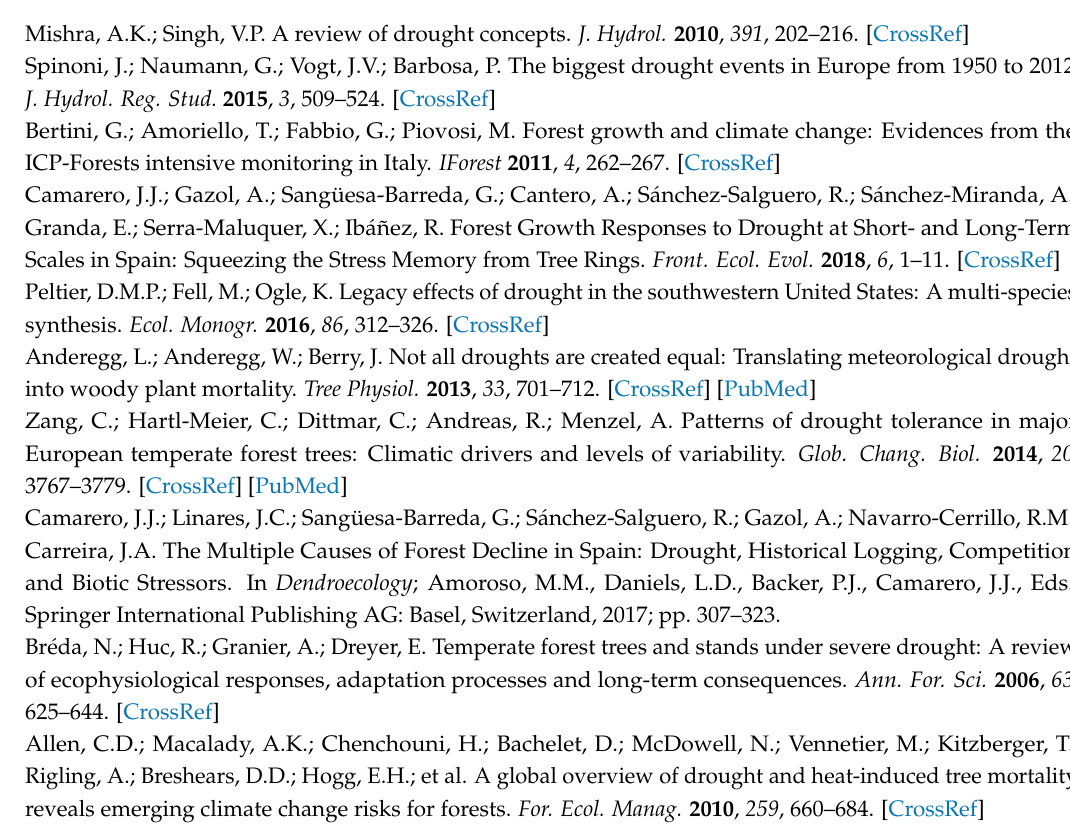
Table S1: Formulas of the applied meteorological and water balance variables, Table S2: The modified Brook90 parameters, Table S3: Mean tree-ring widths (standardized chronologies) before, during and after the drought events (1993, 2000–2003 and 2011–2012). Author Contributions: Conceptualization, N.M. and E.R.; Data curation, B.G. (Bal á zs Garamszegi), G.I. and B.G. (Borb á la G á los); Investigation, N.M., E.R., A.B. and A.H.; Methodology, N.M. and B.G. (Bal á zs Garamszegi); Resources, A.J.; Supervision, Z.V., Z.S. and B.G. (Borb á la G á los); Writing-original draft, N.M., B.G. (Bal á zs Garamszegi), E.R., A.B. and A.H., A.J., G.I., Z.V., Z.S. and B.G. (Borb á la G á los); Writing-review & editing, N.M., Z.V., Z.S. and B.G. (Borb á la G á